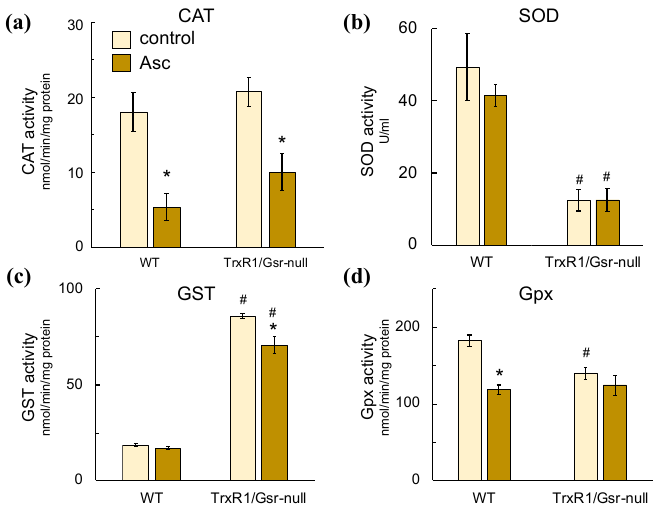
Figure 7. Enzymatic markers of oxidative stress. Enzyme activities of catalase ( a , CAT), superoxide dismutase ( b , SOD), GSH-S-Transferase ( c , GST), and GSH-peroxidase ( d , Gpx) were measured. Mice received 0 (control) or 4 mg/g/day ascorbate × 4 days i.p. (Asc) and were harvested 3 h after the final inoculation. n = 3–5 animals for each condition. Bars, mean ± s.e.m.; *, p ≤ 0.05 versus untreated no-ascorbate control of same genotype; #, p ≤ 0.05 versus WT using one-way ANOVA and Tukey–Kramer post hoc, pair-wise comparison.